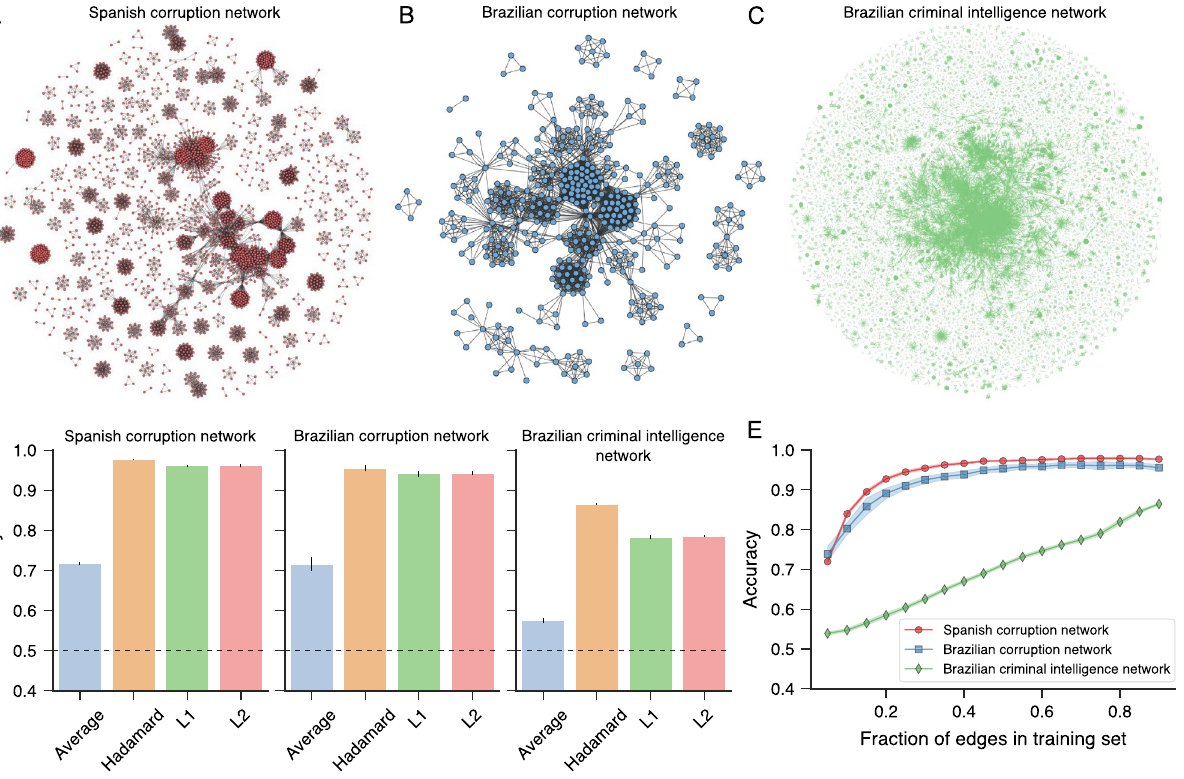
Figure 1. Predicting partnerships in criminal networks. Visualizations of the criminal networks related to ( A ) Spanish corruption cases, ( B ) Brazilian corruption cases, and ( C ) Brazilian criminal intelligence network. In corruption networks, nodes represent people involved in corruption scandals, and connections indicate people participating in the same corruption case. In its turn, nodes in the criminal intelligence network represent people investigated by the Brazilian Federal Police, and an edge between two individuals indicates some co-participation (unlawful or lawful) uncovered by police investigations. ( D ) Accuracy of logistic classifiers trained for predicting missing links with node2vec representations of nodes and different binary operators. The bars stand for the average accuracy estimated from test sets over ten realizations of the embedding and training processes (error bars represent one standard deviation). The test sets are generated by randomly removing 10% of network edges and sampling the same number of false connections. The horizontal dashed lines represent the baseline accuracy (0.5). ( E ) Accuracy of logistic classifiers as a function of the fraction of nodes in the training set for each criminal network. The markers represent the average accuracy estimated from test sets over ten realizations of the embedding and training processes with the Hadamard operator (shaded regions stand for one standard deviation